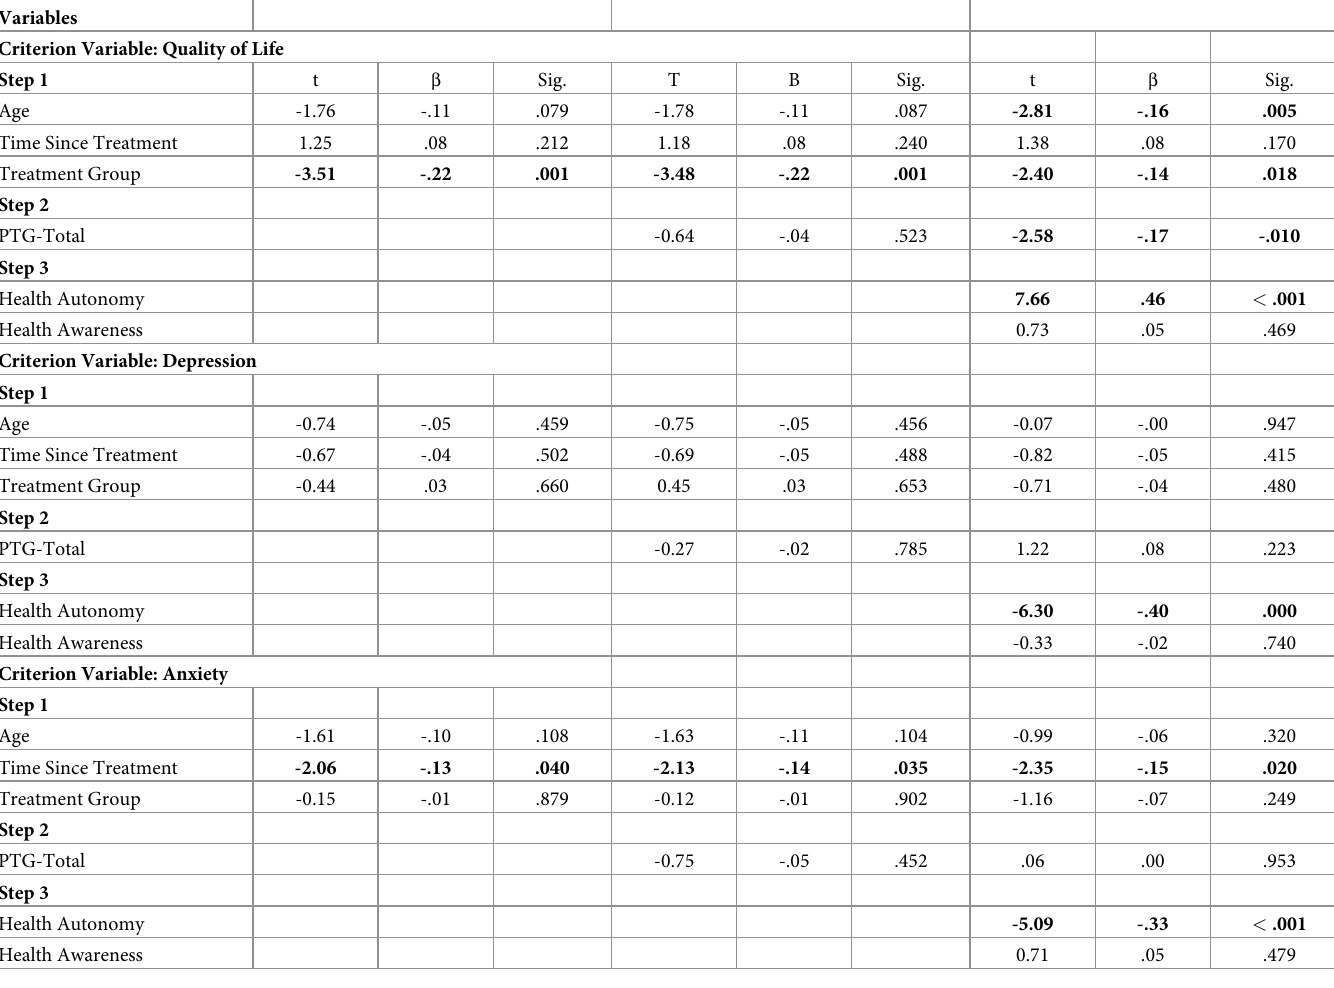
Table 6. Hierarchical linear regressions for demographics, post-traumatic growth (PTG), and physical-post traumatic growth subscales predicting quality of life, depression and anxiety.